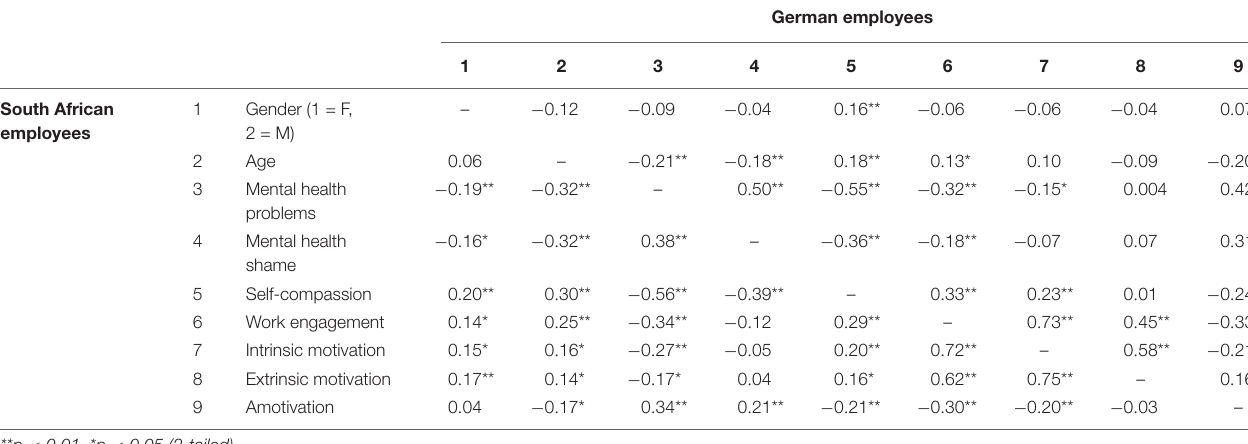
TABLE 2 | Correlations between mental health problems, mental health shame, self-compassion, work engagement and work motivation in German and South African employees.